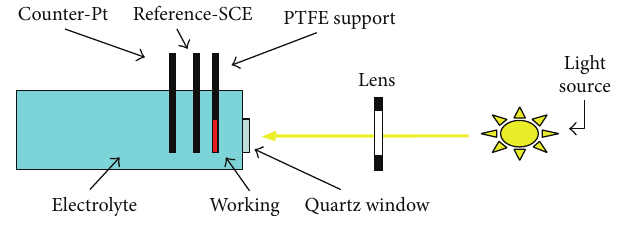
Figure 2: Experimental setup.